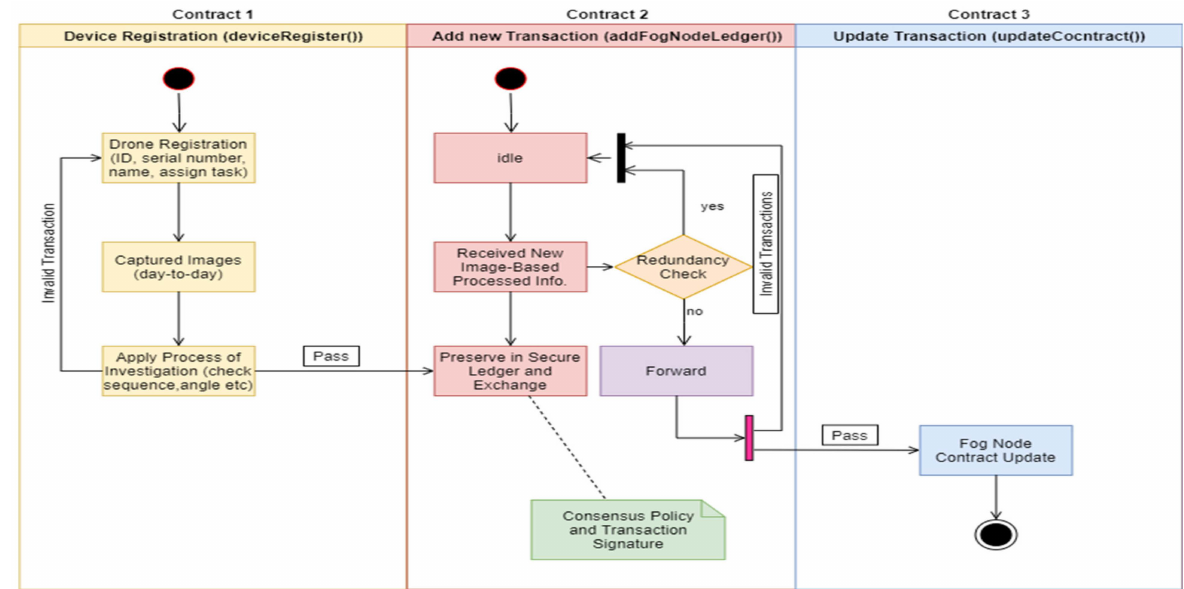
Figure 5. Events of Fog Node Transaction